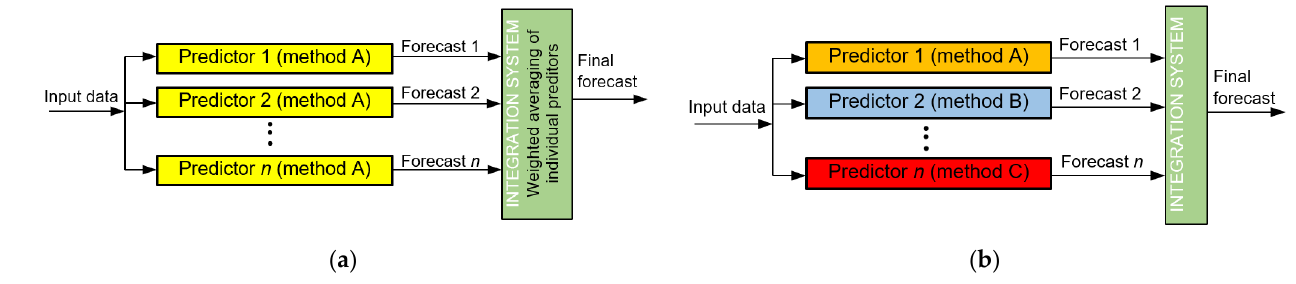
Figure 14. ( a ) General structure of ensemble method with the same type of methods as individual predictors; ( b ) General structure of ensemble method with different types of methods as individual predictors.